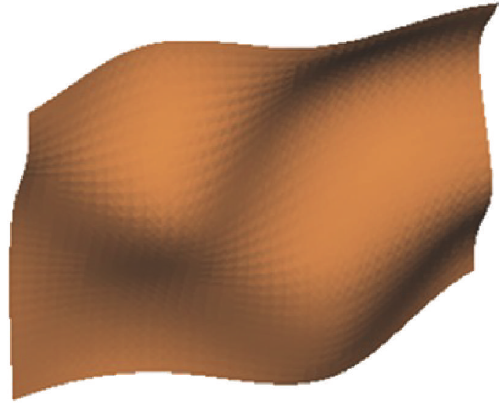
Figure 8: Final surface model.